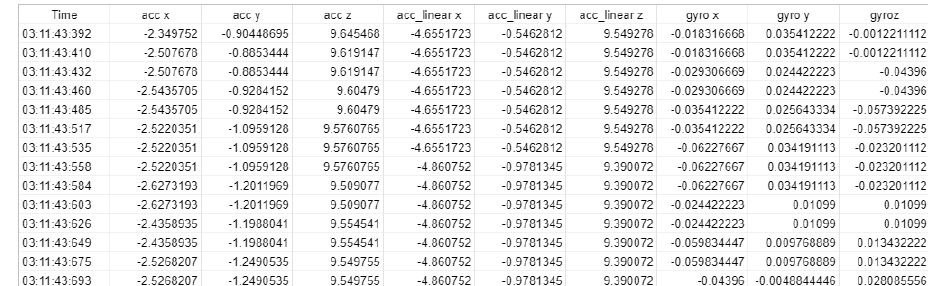
Figure 5. Example of collected data (digit 0) from a smartwatch.